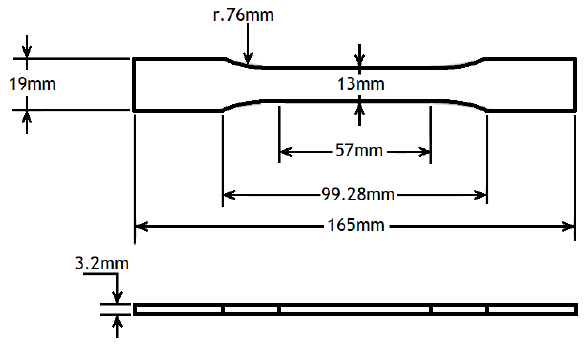
Figure 2: The specification of tensile test specimen